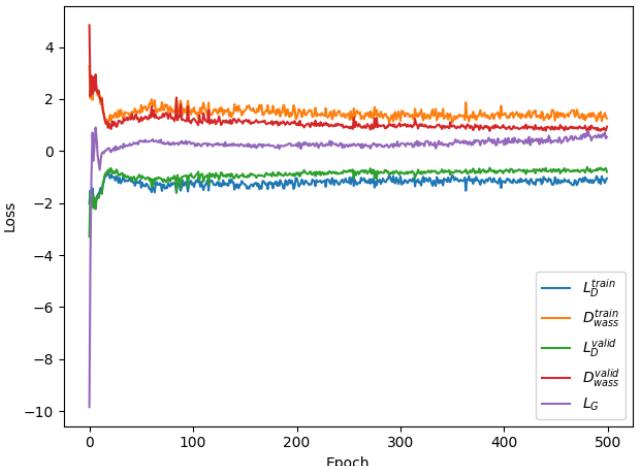
Figure 4. The changes of the loss indicators for the generator and discriminator.